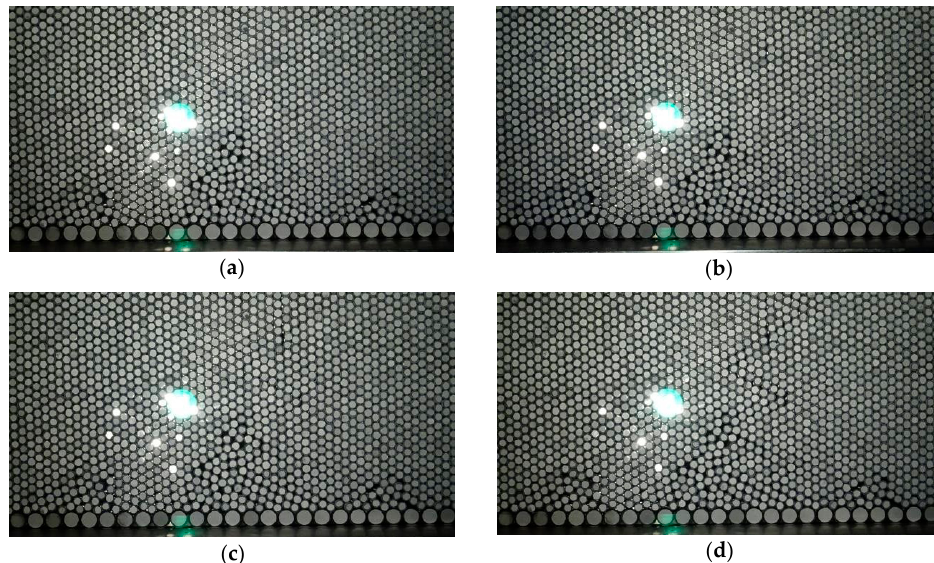
Figure 14. Evolution of structural imperfections under shallow foundation loading: (a) 0 mm (Figure 13a); (b) 3.22 mm (Figure 13c); (c) 4.96 mm (Figure 13e); (d) 5.83 mm (Figure 13g).